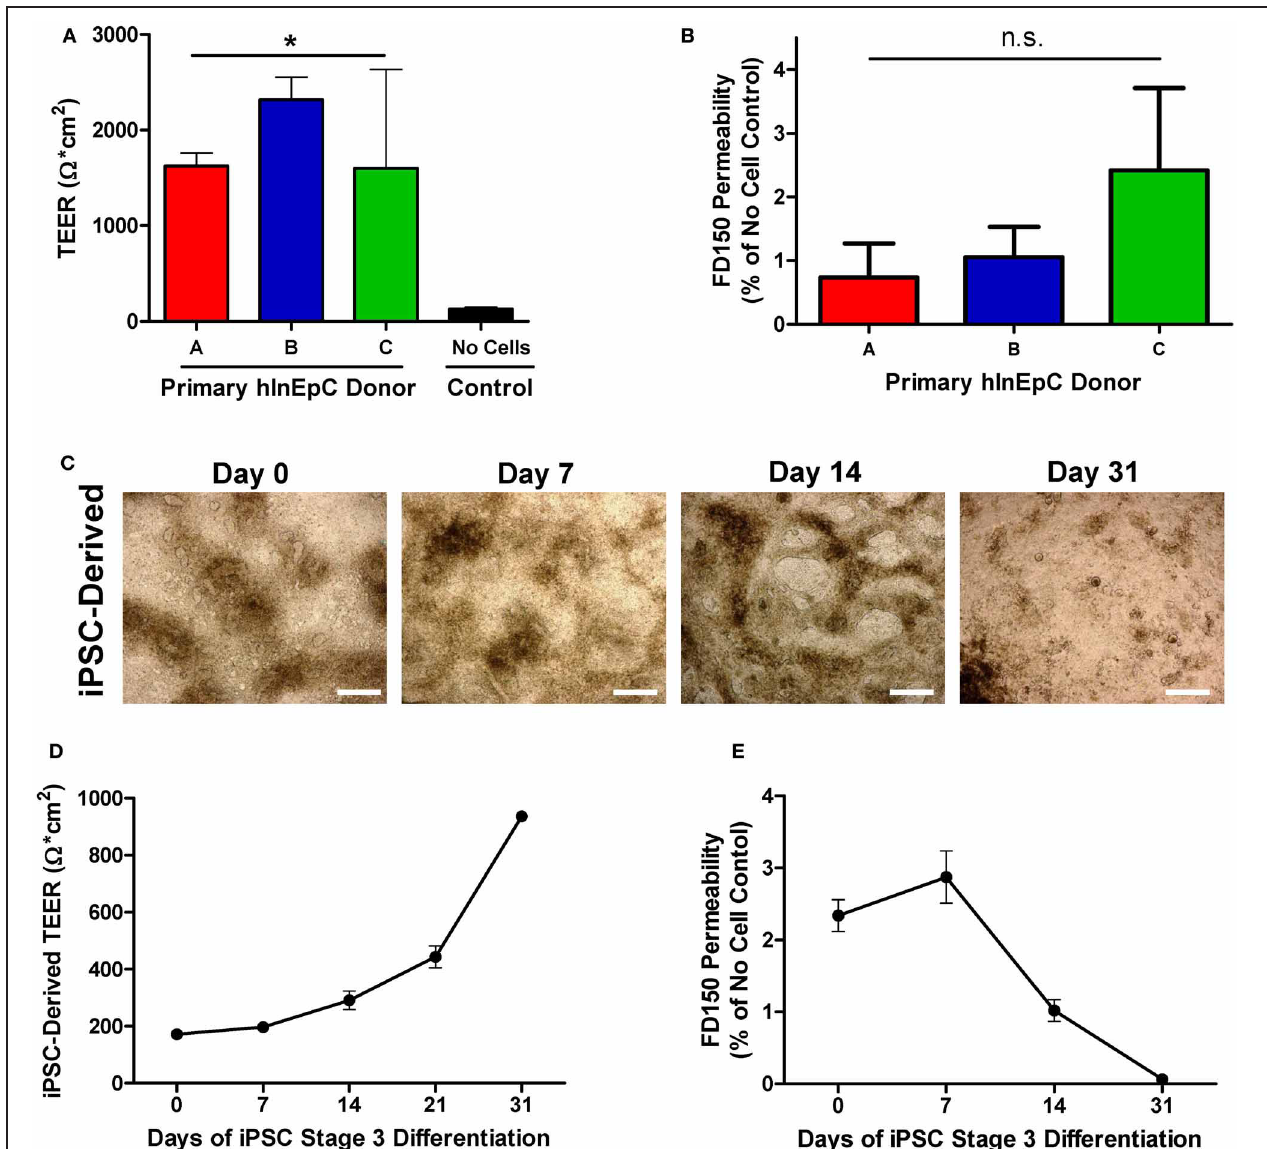
monolayer-like cells by Day 31. Scale bar, 250 μ m. (D) Differentiating iPSCs (cell line A1145A shown) are capable of exhibiting increasing TEER during Stage 3 differentiation, reaching > 900 (cid:2) × cm 2 by Day 31. (E) A1145A cells exhibit low FD150 permeability with increasing days in Stage 3 culture relative to no-cell control. N ≥ 3; Error bars represent SEM. For panels (A) and (B) , significance was determined by One-Way ANOVA, ∗ p < 0 .